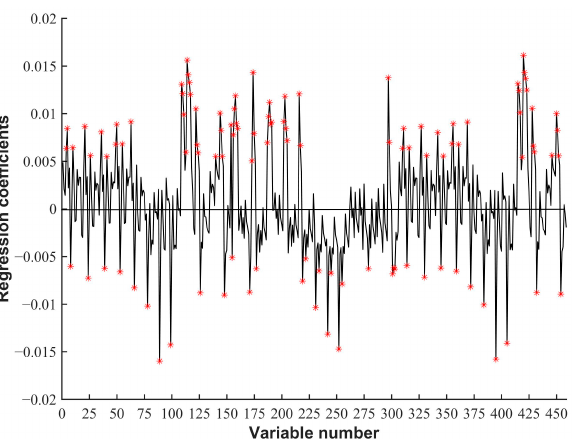
Figure 7. Regression coefficients of PLS-DA model based on combination of spectral characteristic variables.